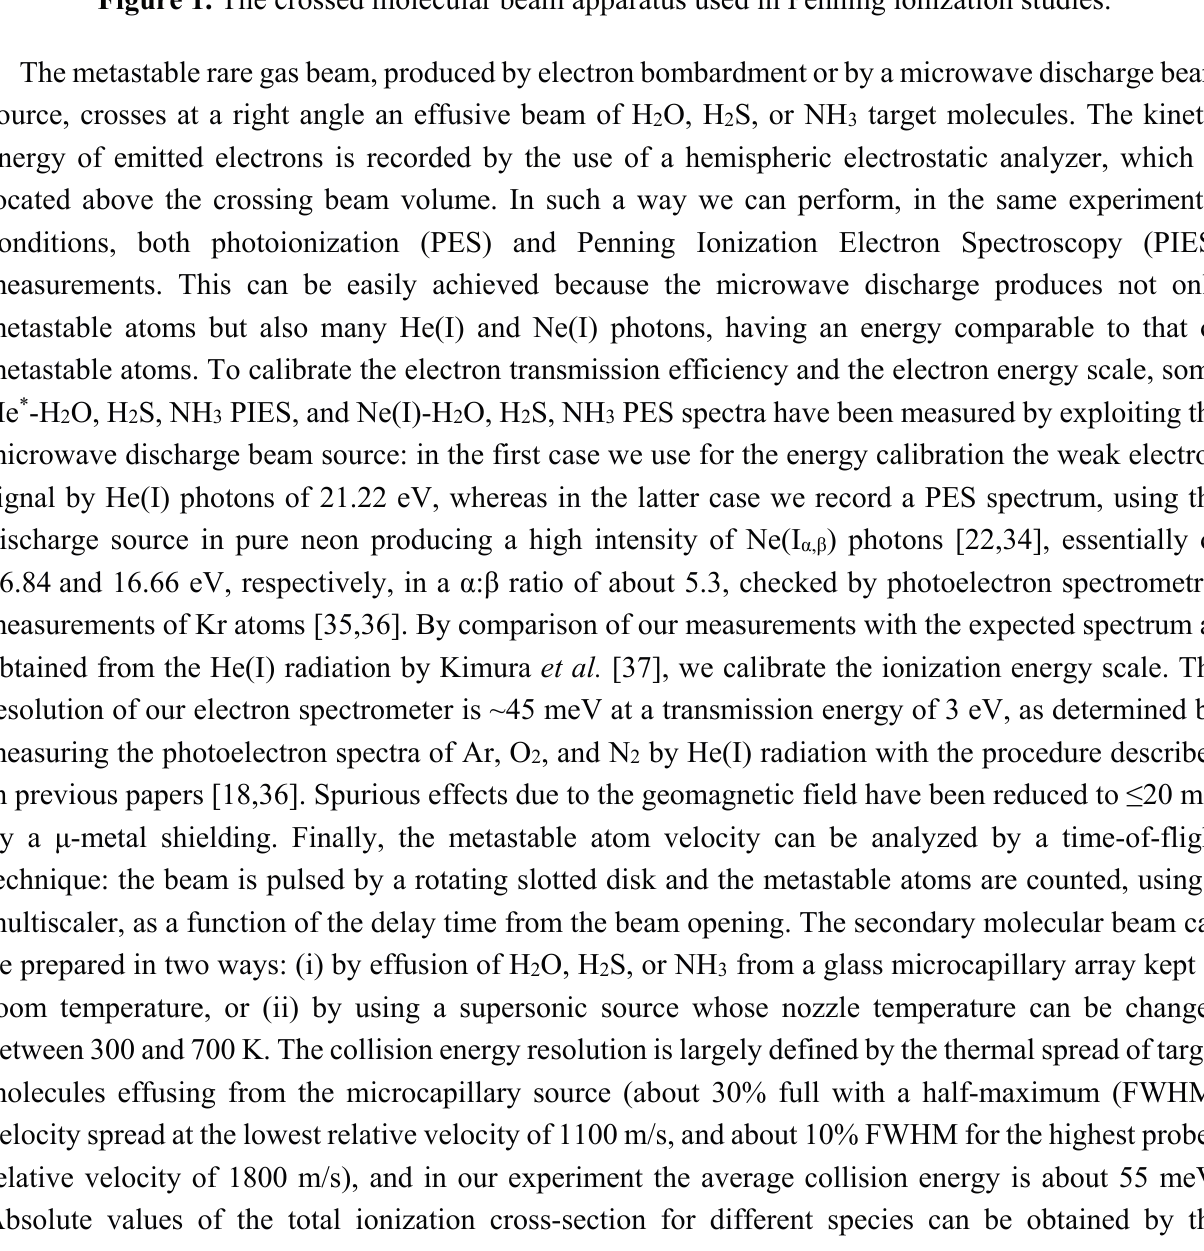
Figure 1. The crossed molecular beam apparatus used in Penning ionization